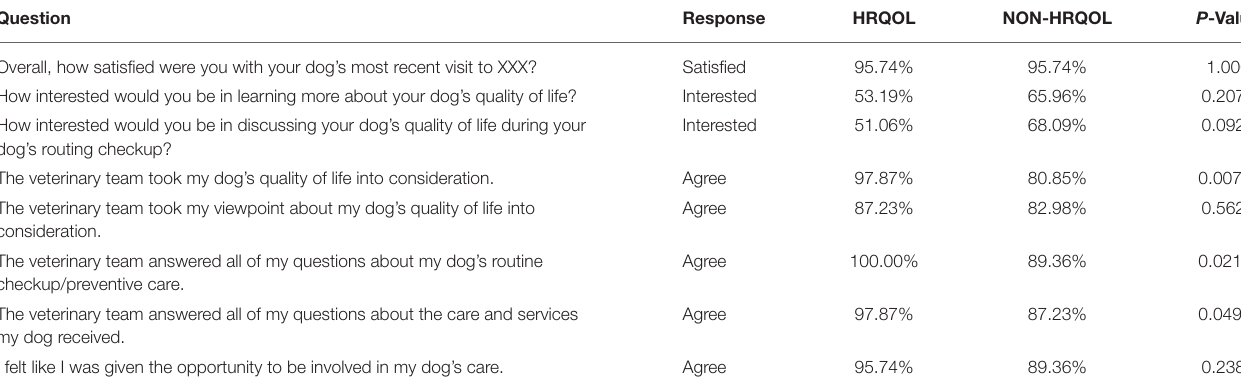
TABLE 3 | Phase 2 Visit assessment comparison HRQOL vs. non HRQOL groups.